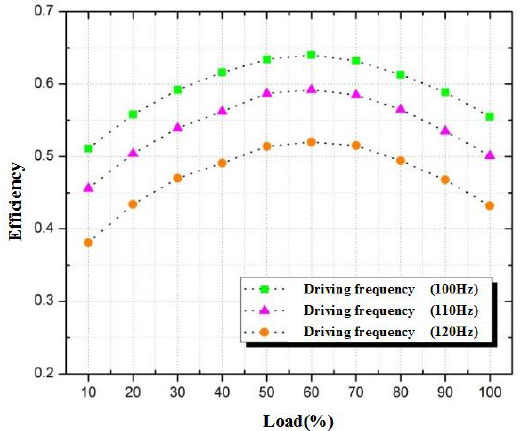
Figure 15. Efficiency vs. load for the three different driving frequencies.